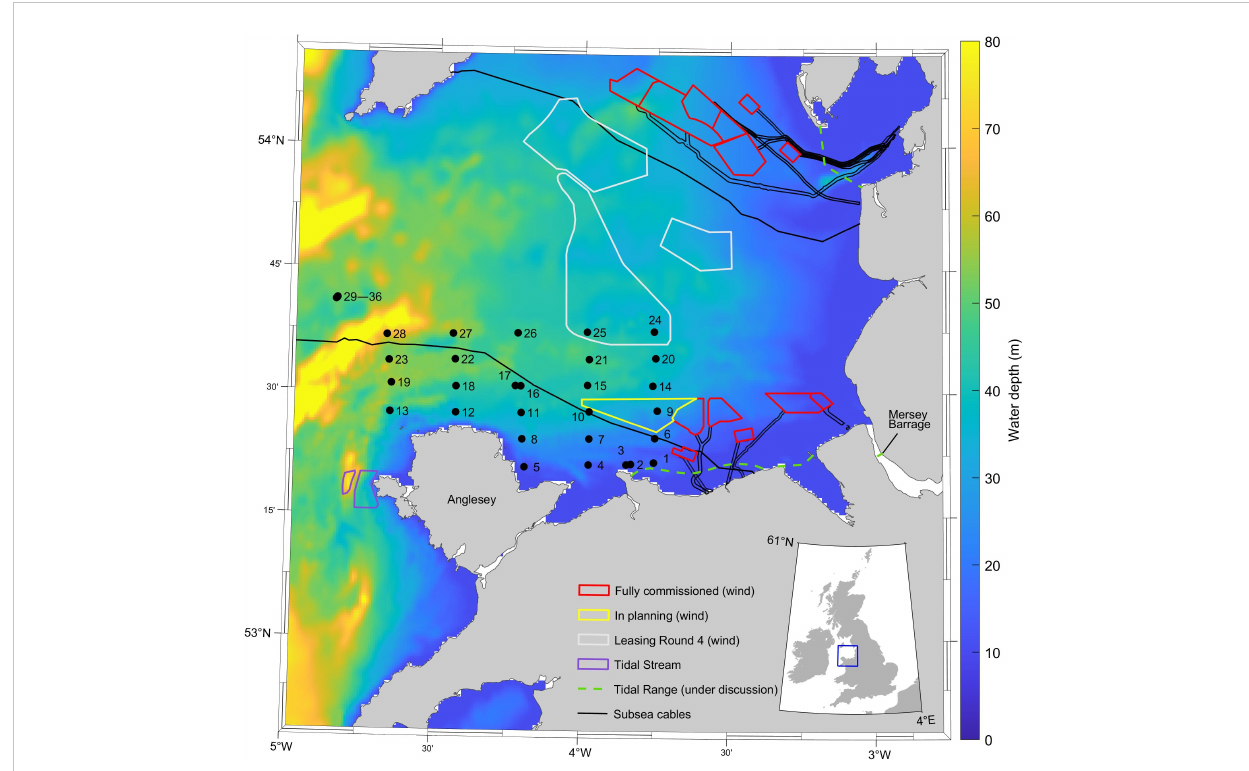
FIGURE 1 Map of sample locations in the Irish Sea and location of existing and proposed wind farms, tidal stream consented sites and tidal range proposed sites. Background color scale is bathymetry (from GEBCO) in meters relative to mean sea level. Wind farm, cables and tidal stream data from The Crown